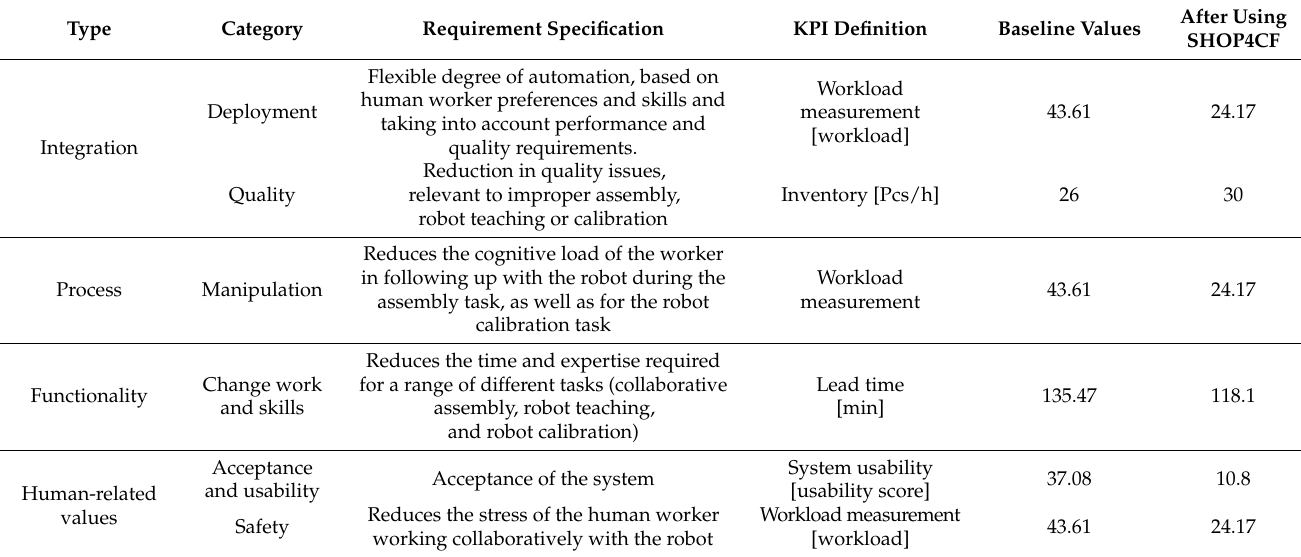
Table 1. KPI definition for Siemens UC.